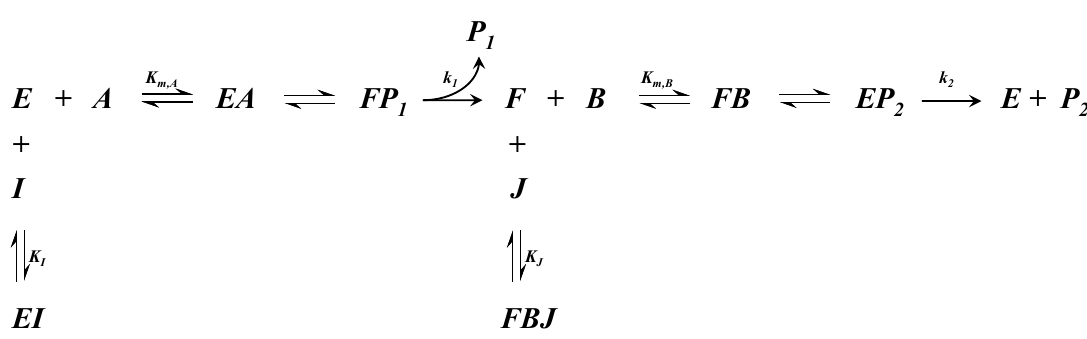
Figure A4. Ping-pong bi-bi kinetics and competitive inhibition of species A through I and species B competing with J.